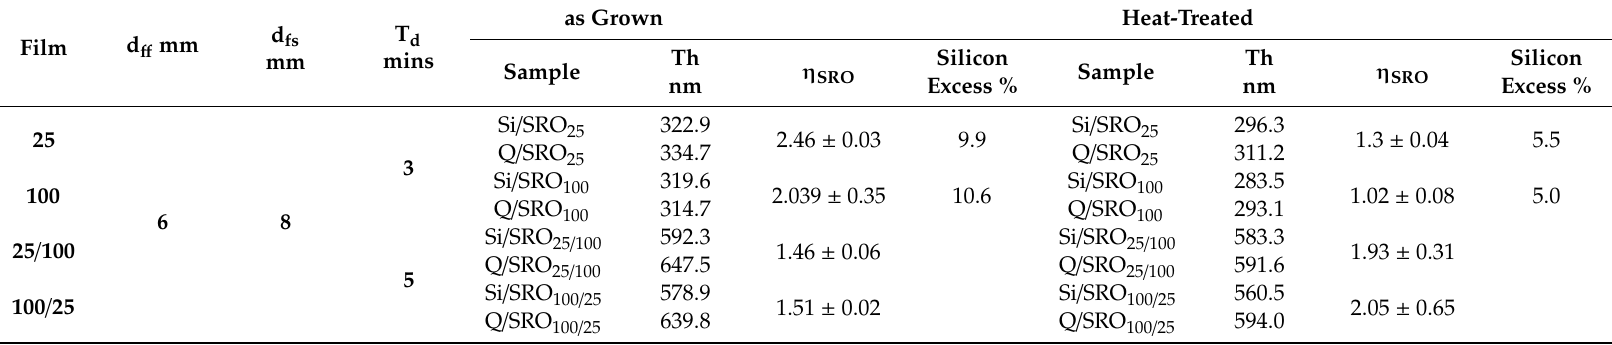
Table 1. Parameters of manufacture, labeling thickness (Th) and refractive index of the Silicon-Rich Oxide (SRO) films ( η SRO ) as-grown (as-G) and heat-treated (HT). as Grown Heat-Treated T d d fs Film d ff mm mins mm